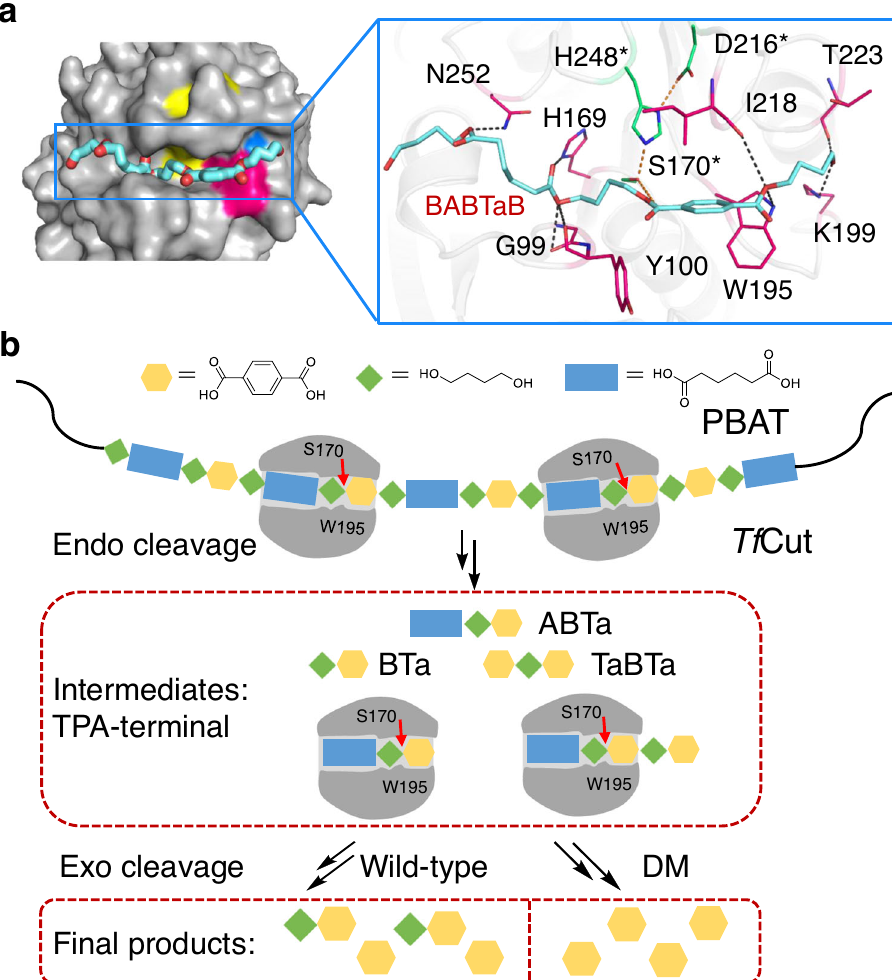
Fig. 5 | Tf Cut-catalyzed PBAT degradation. a The predicted binding mode of the polymer chain of PBAT in the active site tunnel of Tf Cut-DM. The polymer chain is drawn as BABTaB (cyan sticks). The catalytic triad, W195, and DM are colored in yellow, magenta, and blue, respectively. The zoom in fi gure is shown on the right side.The interaction network of BABTaBwith surrounding residues in Tf Cut-DM is showninmagentasticksandgraydashlines(<3.5Å).Thecatalytictriadresiduesare